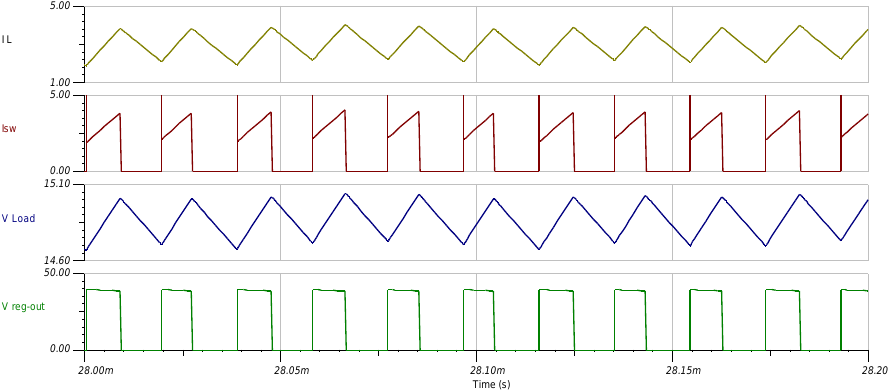
Figure 5. Graph curves of the quantities of the investigated converter obtained by simulation in the TINA program.